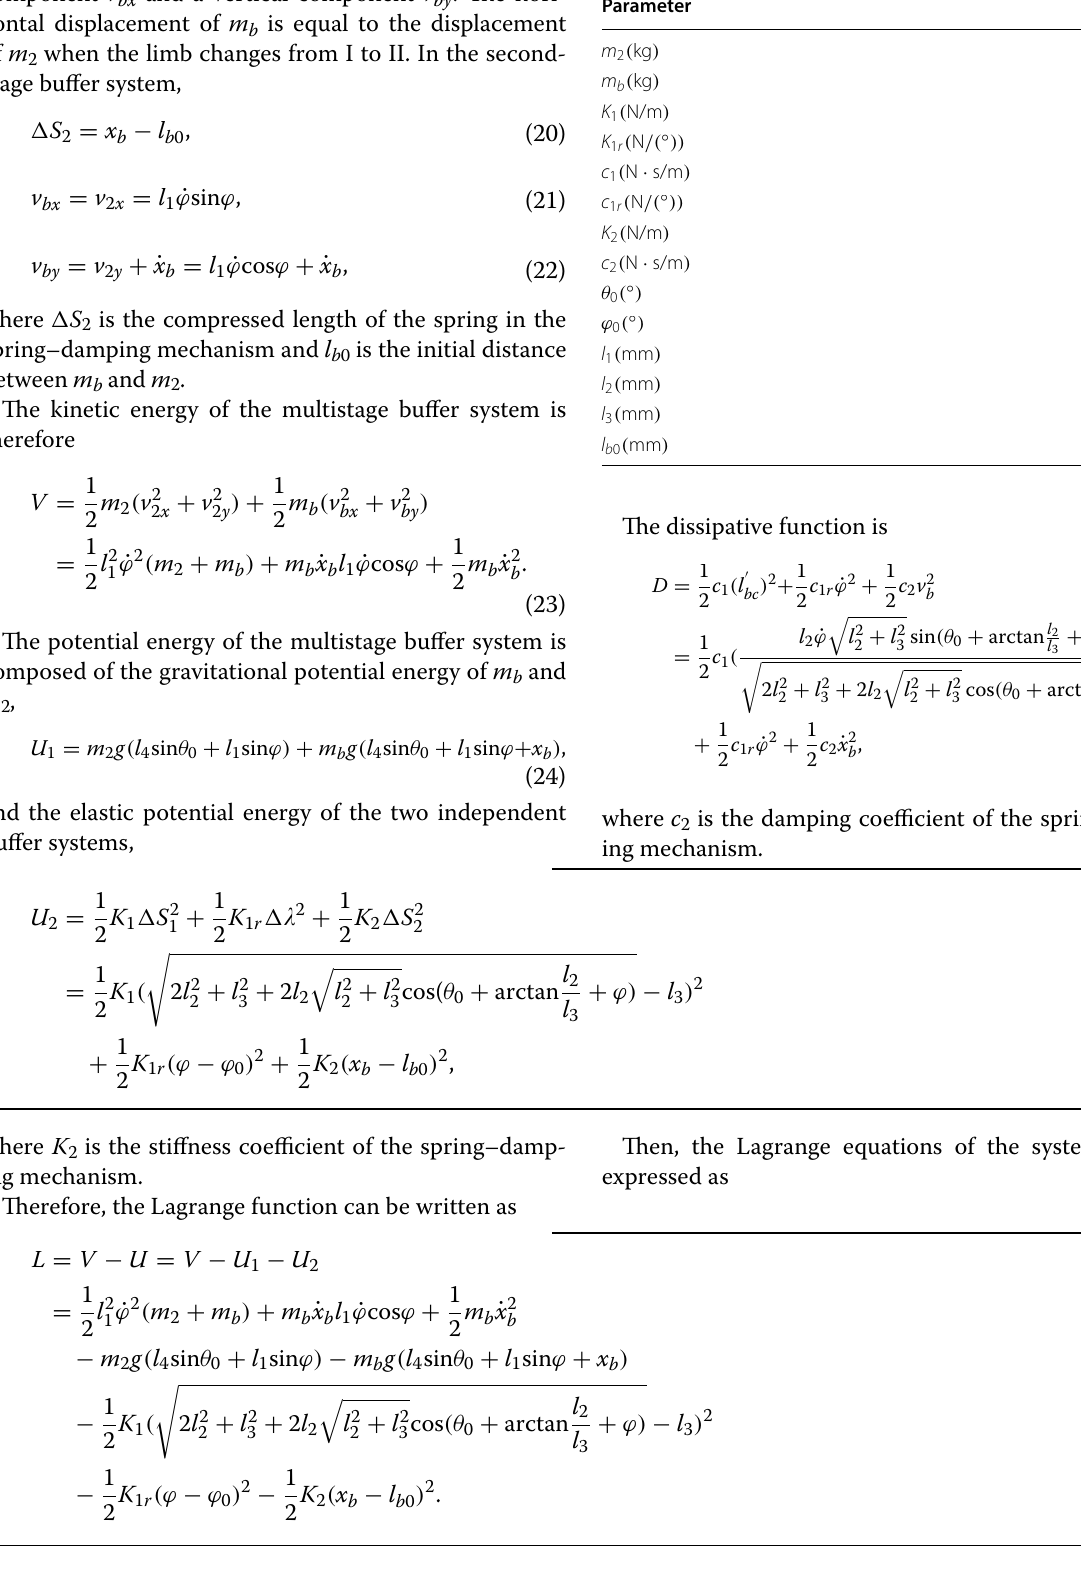
Table 2 Design parameters of the multistage buffer system